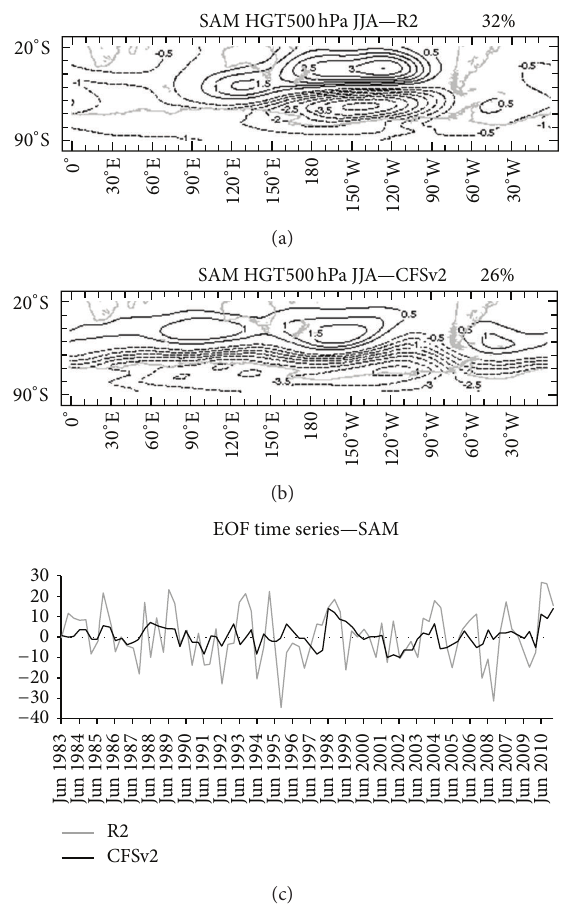
Figure 12: Southern Annular Mode (SAM) captured from mean geopotential height at 850 hPa over 20 ∘ –90 ∘ S during JJA season at 0- monthleadfor(a)CFSv2and(b)R2data;(c)thecorrespondingEOF time series which gray (black) line is related to R2 (CFSv2). Contour interval is 1hPa from 0.5 gpm and negative contours are dotted. (a) and (b) are adapted from IRI/LDEO Climate Data